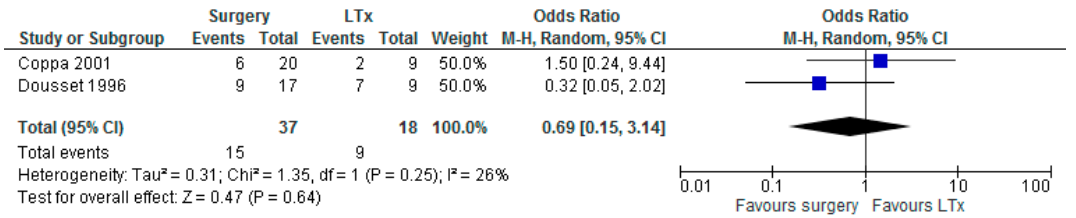
Figure 6. Forest plot for overall survival (OS) after any surgery versus liver transplantation (LTx).